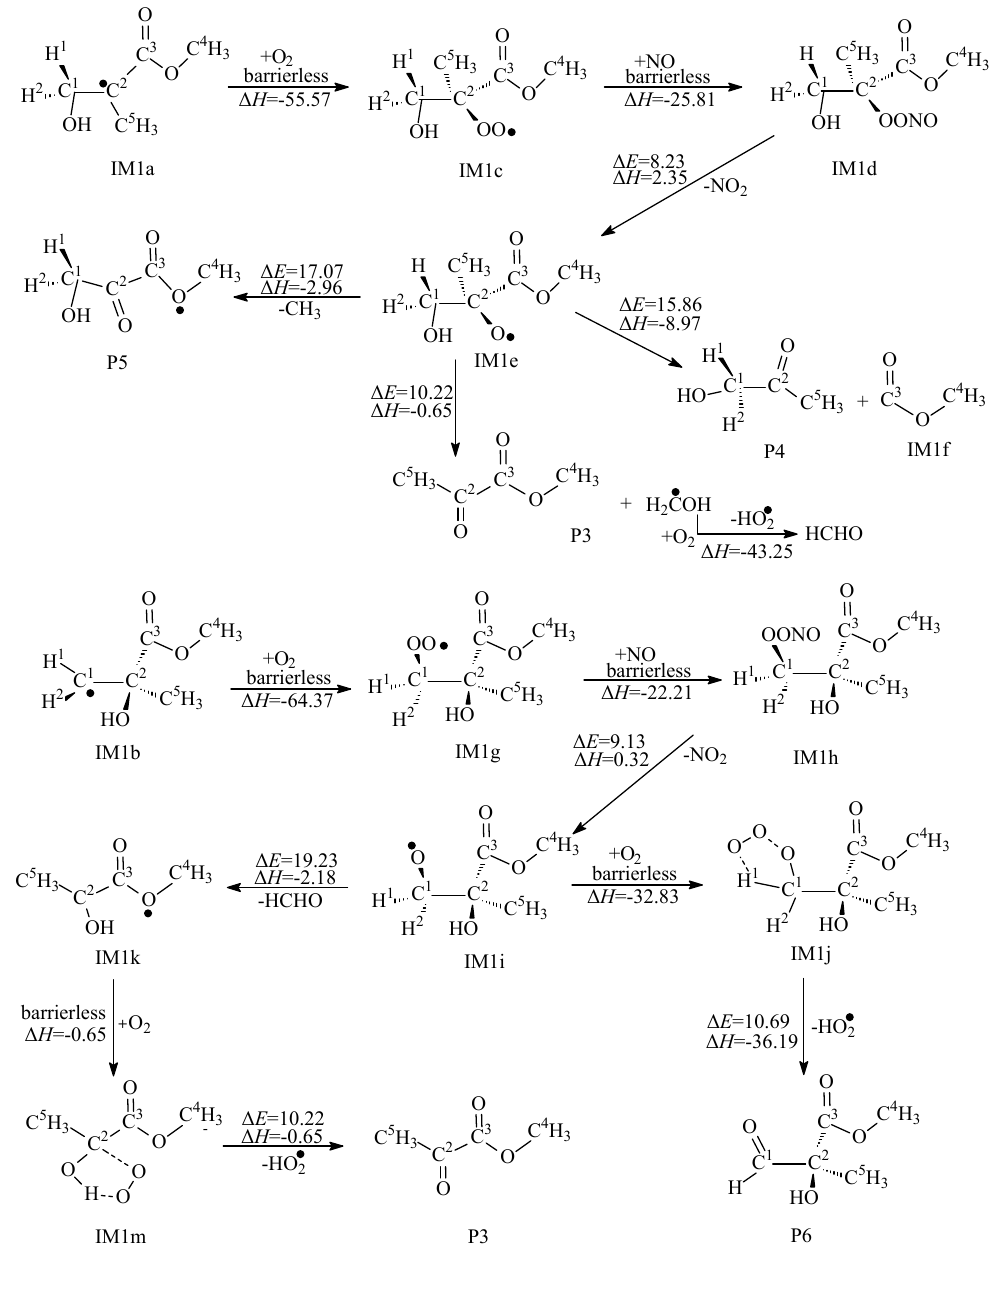
Figure 4. Secondary reaction of IM1a and IM1b. Unit: kcal/mol. Δ E : the potential barriers; Δ H : reaction heats (0